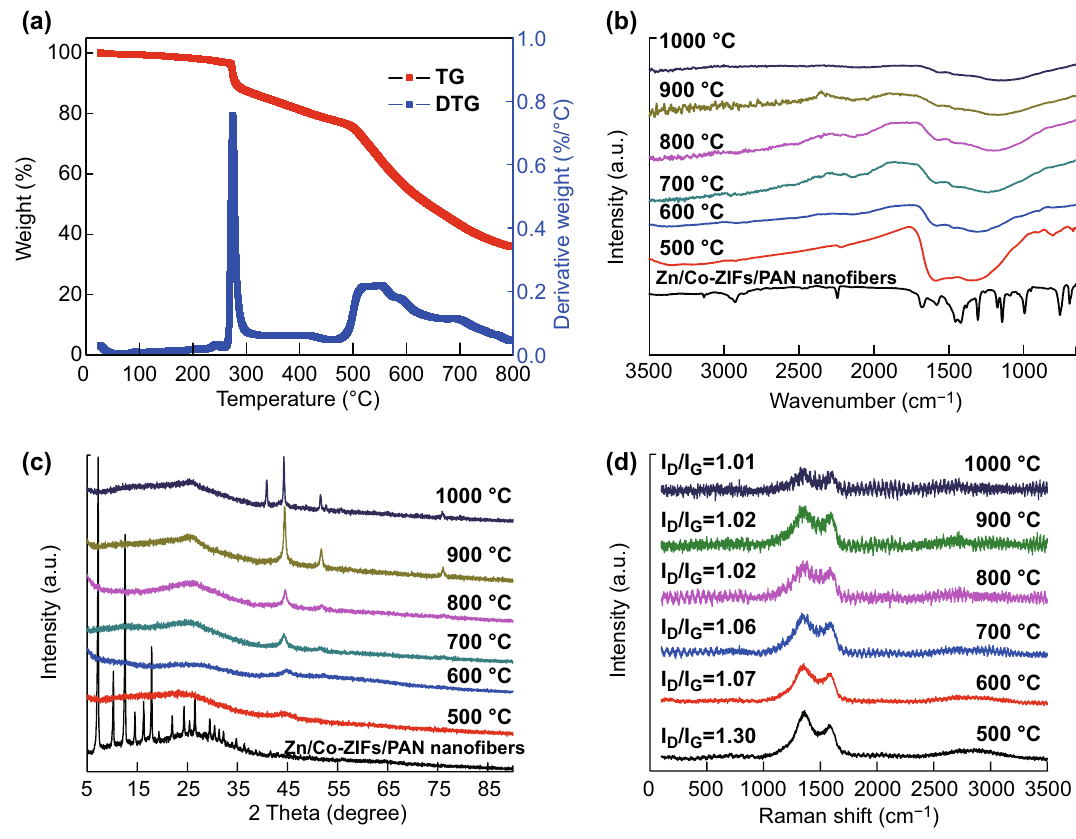
Fig. 3 a TG and DTG curves of Zn/Co-ZIFs/PAN nanofibers. b FT-IR spectra, c XRD patterns, and d Raman spectra of Zn/Co-ZIFs/PAN nanofibers and their carbonized samples with different carbonization temperatures (500, 600, 700, 800, 900, and 1000